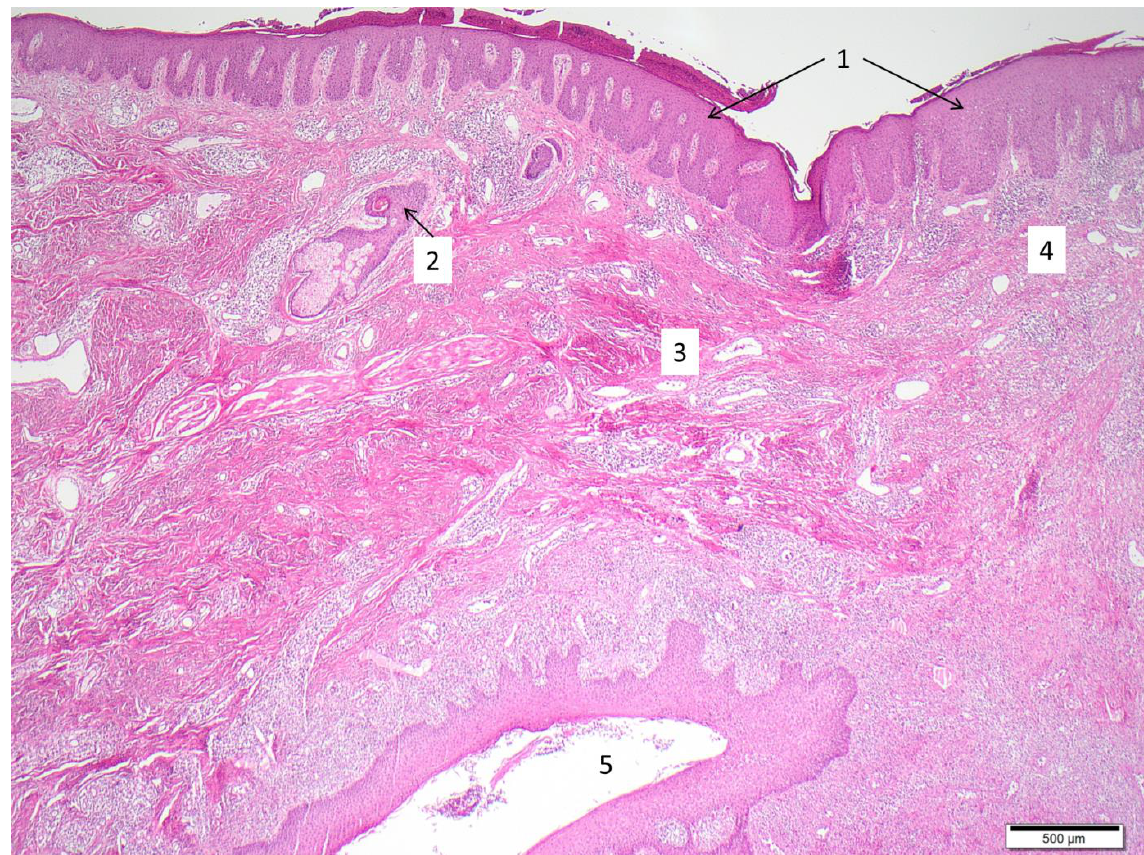
Figure 2. Typical histological features of HS. Sample acquired by punch biopsy from gluteal region. Hyperparakeratosis and papillomatosis (1), follicular hyperkeratosis and perifolliculitis (2), fibrosis (3), abscess-like accumulation of neutrophils and spotted infiltrate of lymphocytes/plasma cells (4), epithelialized sinus tract with surrounding inflammatory reaction (5).